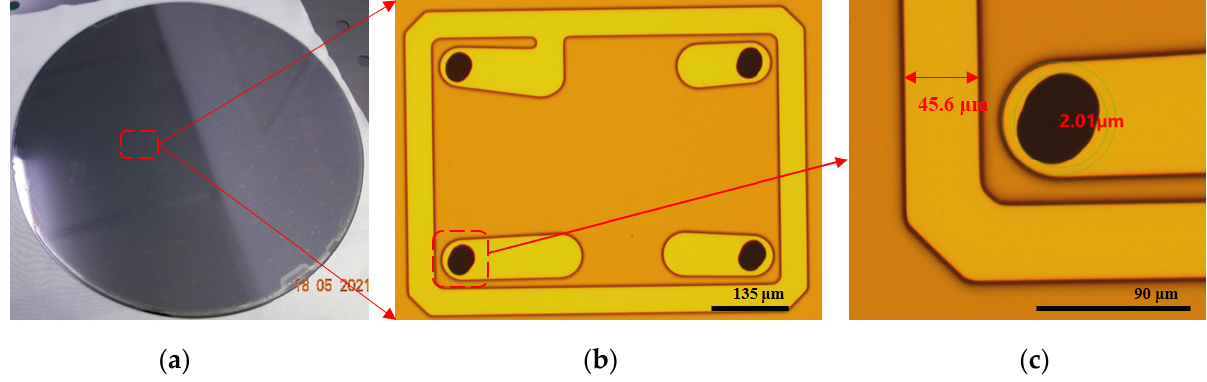
Figure 8. The first and second metal RDL lines. ( a ) The whole glass cap wafer with bond frame structure. ( b ) The OM image of the first RDL line. ( c ) The shift value of TGV and the first RDL line.